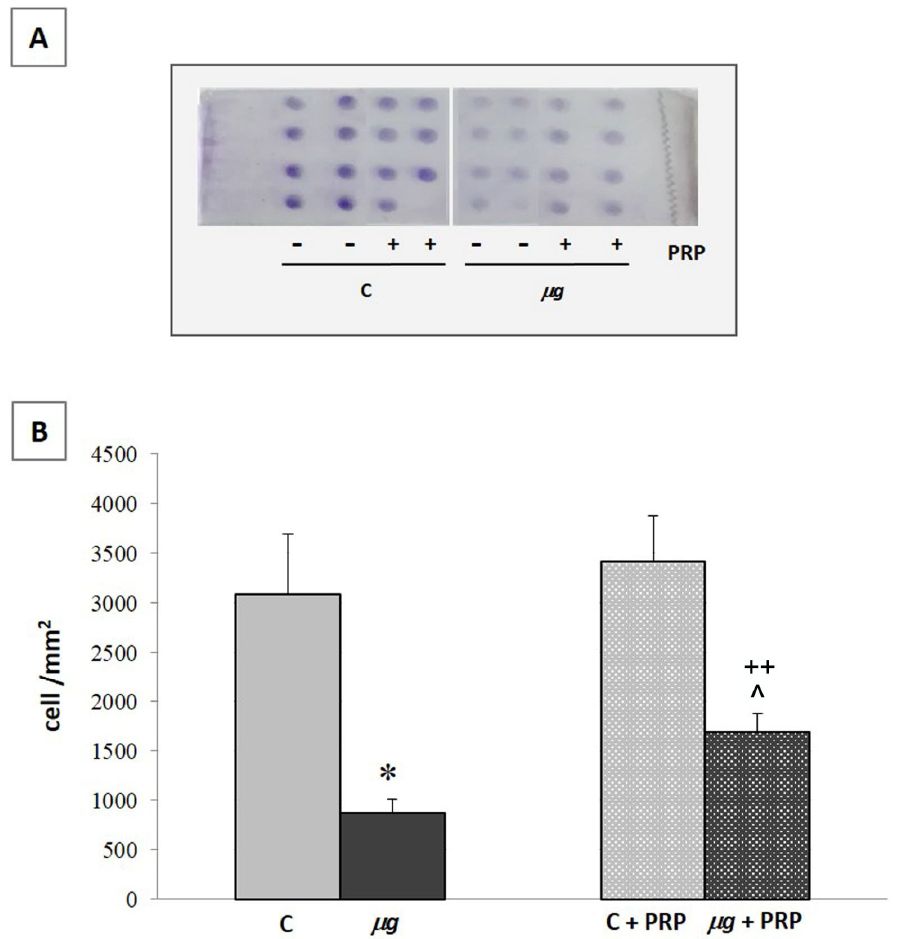
Figure 10. Effect of PRP treatment on NIH-3T3 cells exposed to modeled μg : cell migration—Boyden chamber assay. The Boyden chamber assay was performed immediately after 72 h exposure to modeled μg , with or without PRP addition (1:1000). C = 1 × g . Representative images of the assay ( A ); number of migrated cells ( B ). * p < 0.05 vs. C, ++ p < 0.05 vs. μg, ^ p < 0.05 vs. C + PRP, ( n = 3).